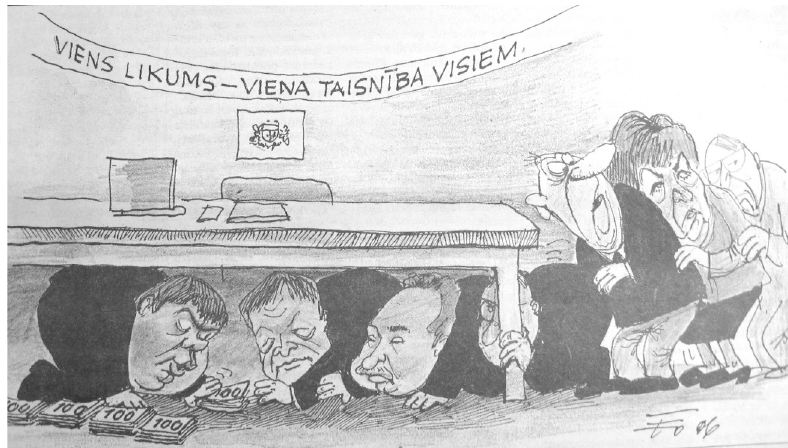
Fig. 1. Written on sign: “One law, one justice to all”. Author: Ē riks